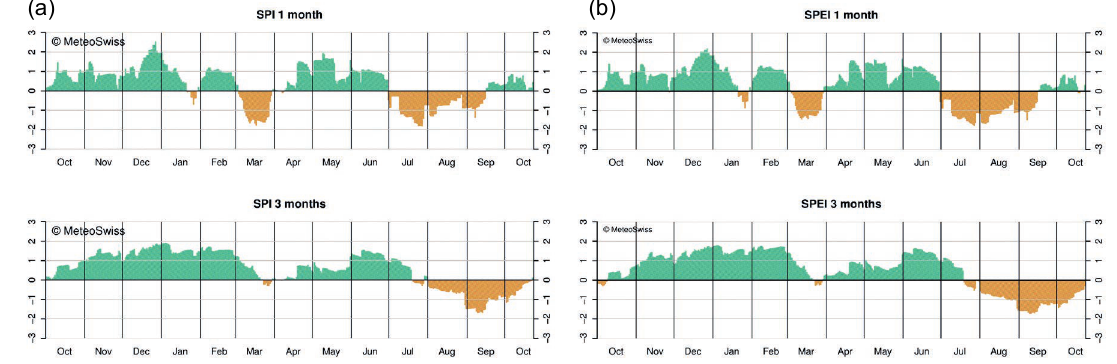
Fig. 1 Visualization of the Standardized Precipitation Index (SPI, (a)) and of the Standardized Precipitation Evapotranspiration Index (SPEI, (b)) for accumulated series of one month (top panels) and three months (bottom panels). The situation depicted refers to the MeteoSwiss location “Zürich Fluntern” and for the period going from 1 October 2012 to 23 October 2013.